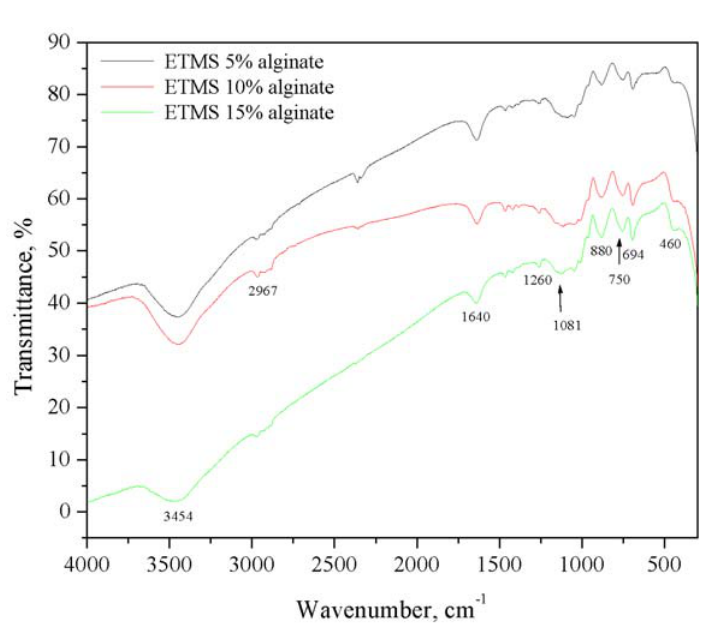
Fig. 5 FT-IR-spectra silica nanocomposite hybrid (ETMS) containing different quantity Calcium alginate.